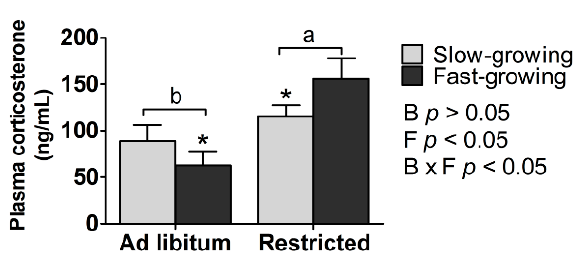
Figure 3. Plasma corticosterone concentration. a, b represent the significant difference between the